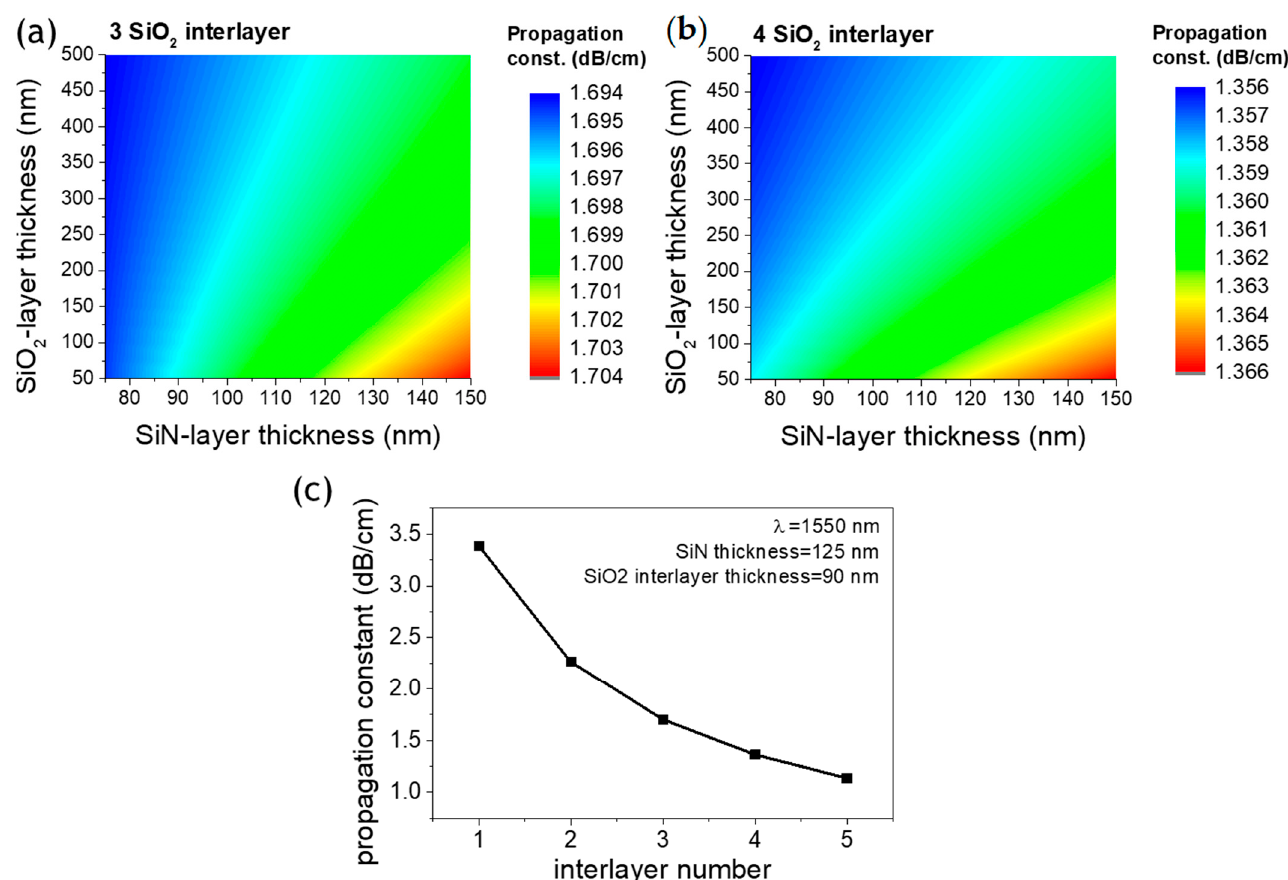
Figure 6. Propagation constant was plotted as function of SiO 2 and SiN thickness for ( a ) 3 SiO 2 interlayers and ( b ) 4 SiO 2 interlayers. ( c ) the propagation constant is given as a function of the number of interlayers. The layer thickness was fixed at 125 nm for SiN layers and at 90 nm for SiO 2 layers.